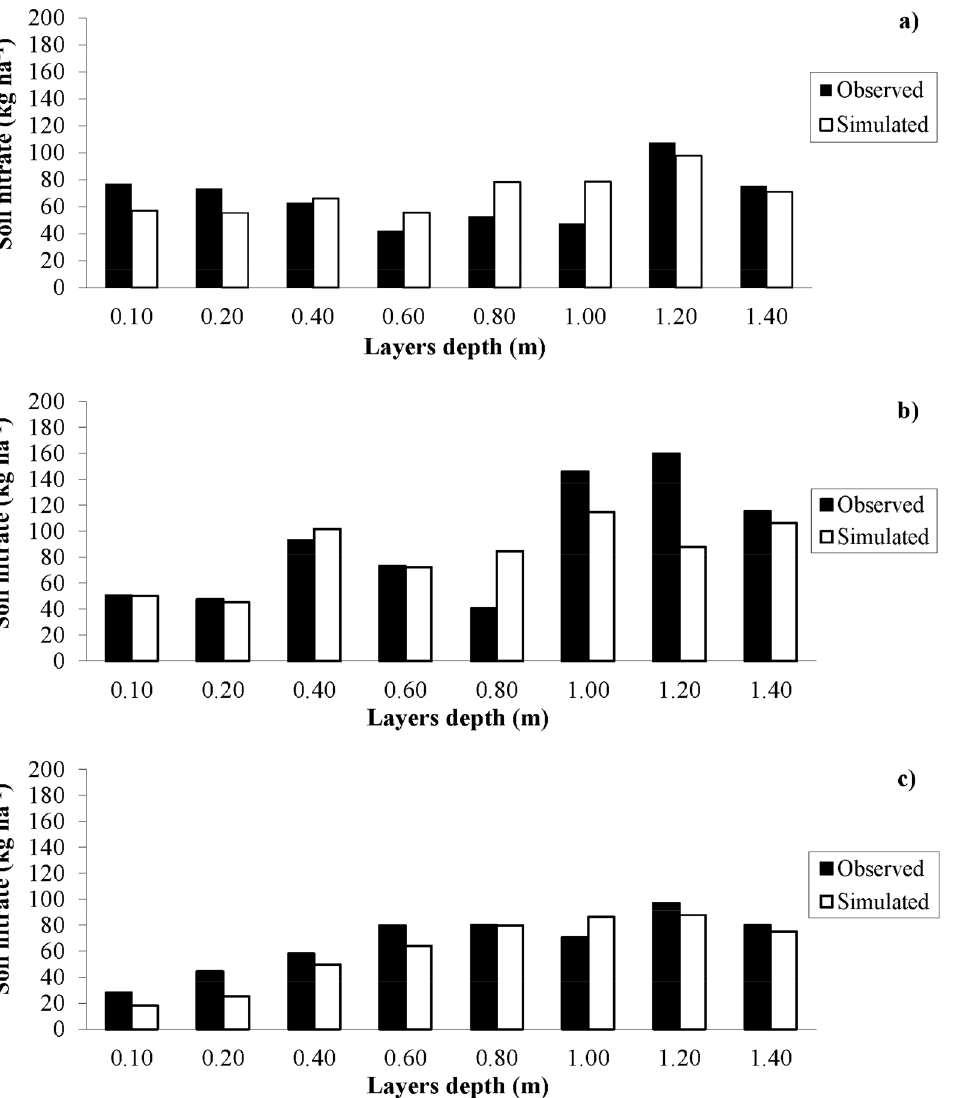
Fig 3. Observed and simulated soil profile nitrate content. Observed (filled bars) and simulated (open bars) nitrate (NO3-) content in soil profile layers for the NMIN (a), CONV (b) and N0 (c) treatments on August 18,